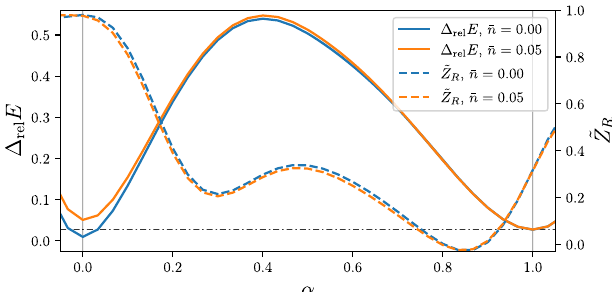
FIG. 10. Numerical simulation of the Ansatz circuit in Fig. 1 for a range of parameter sets θ ð α Þ parametrized by α (see the text) for the mean phonon numbers ¯ n ¼ 0 and ¯ n ¼ 0 . 05 . The left vertical axis gives the relative energy error of the obtained states with respect to the exact ground-state energy of the ESSH model at δ ¼ 4 , t 0 . 333 ; the right axis gives the corresponding value of − ¼ ˜ Z partial-reflection MBTI R